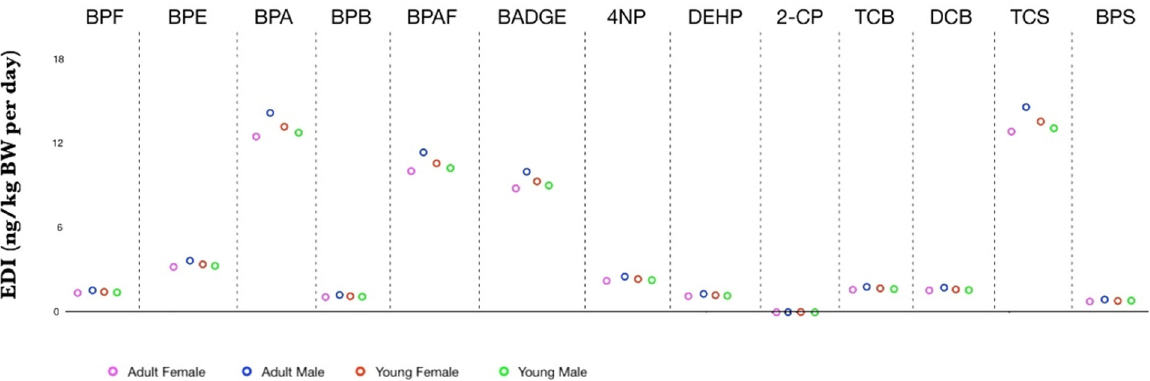
Figure 1. Estimated daily intake (ng/kg BW per day) of detected EDCs via drinking water consumption for age and gender-specific groups. Table 6. Calculated EDI/TDI ratio for adult and young, male, and female, based on TDI EFSA